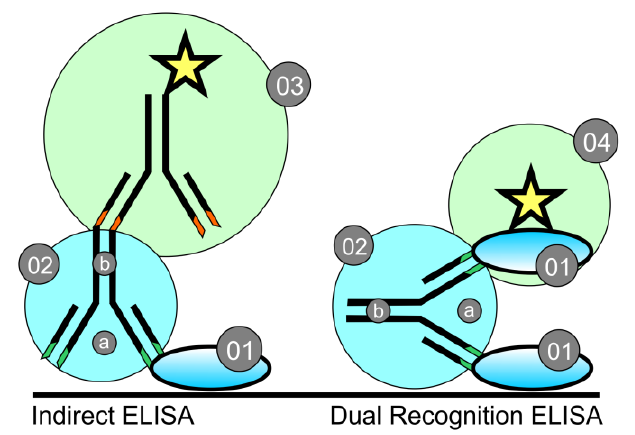
Figure 1. Schematic comparison between indirect ELISA (left) and dual recognition ELISA (right) (inspired by [13]). 01 — fixed antigen (Ag); 02 — specific antibody (Ab): (a) variable region of the specific Ab; (b) Fc — species-specific region of the Ab; 03 — conjugate with labeled (an enzyme represented as a star) secondary Ab for indirect ELISA; 04 – conjugate with labeled Ag for dual recognition ELISA.